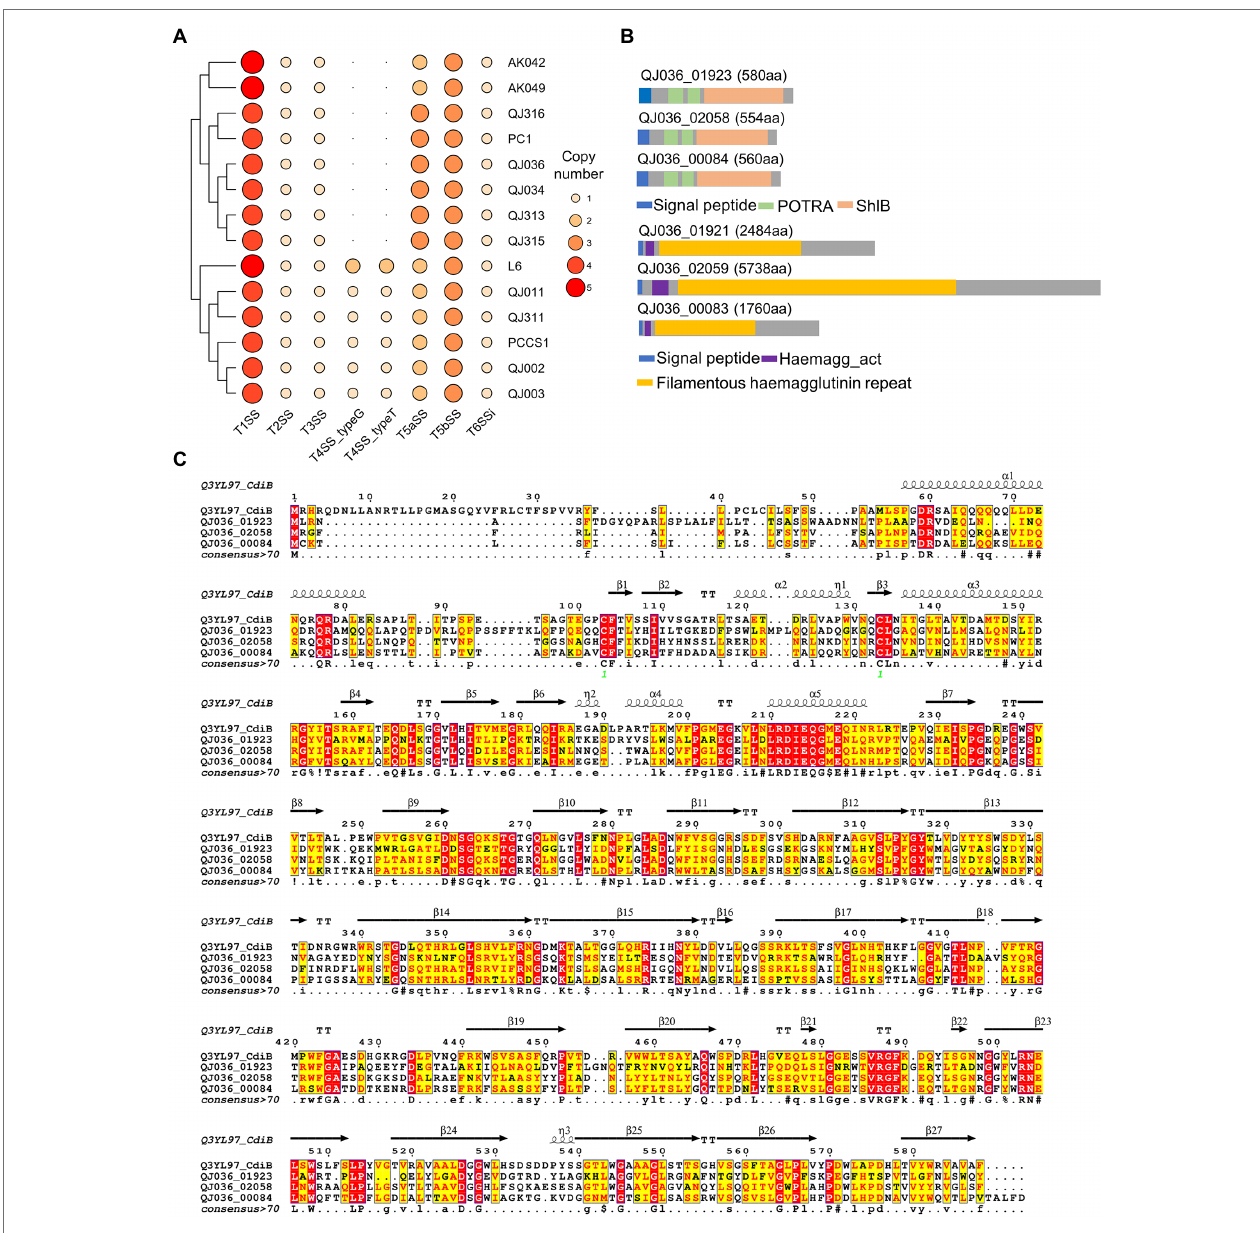
FIGURE 5 | Prediction of bacterial secretion systems in Pectobacterium aroidearum strains. (A) The heatmap shows the distribution of bacterial secretion systems in P . aroidearum strains. (B) Predicted domains in three putative T5bSS proteins of P . aroidearum QJ036 using the online software InterProScan. (C) Sequence similarities and secondary structure elements from aligned sequences of putative T5bSS proteins and CdiB were rendered by the webserver ESPript 3. The secondary structure depiction is based on CdiB (PDB: